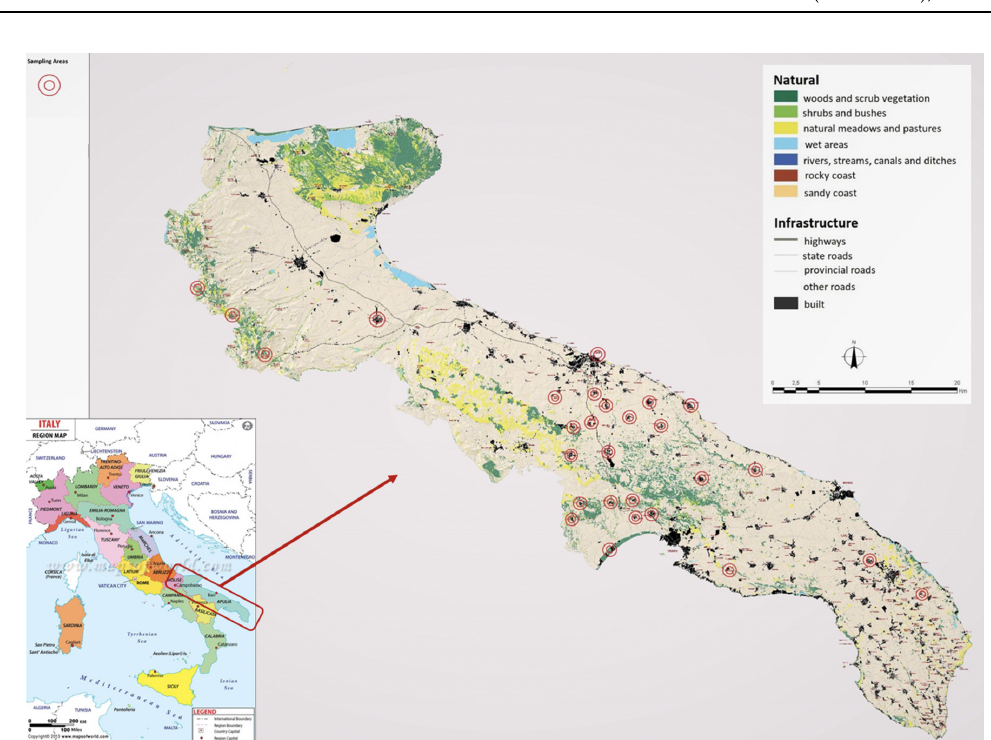
Table 1. Characteristics of the different production areas of the 98 collected honey samples. Sample No.